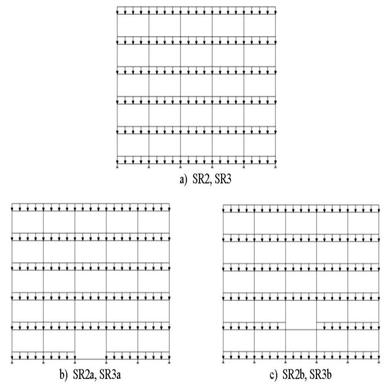
Load cases: a) fully loaded rack frame, b) unloaded beam at the first level and c) unloaded beam at the second level.